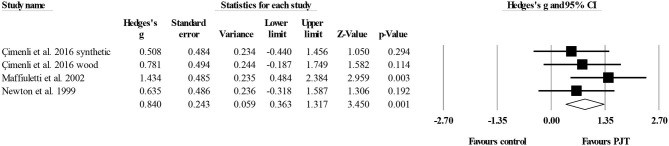
Forest plot of changes in spike jump performance in volleyball players participating in plyometric jump training (PJT) compared to controls. Values shown are effect sizes (Hedges's g) with 95% confidence intervals (CI). The size of the plotted squares reflects the statistical weight of the study.